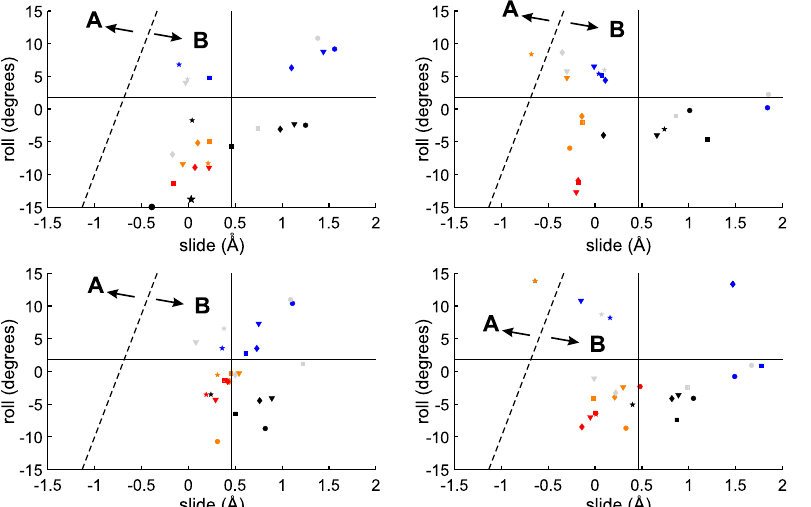
Figure 4. Predicted slide and roll coordinates of single-stranded hexamers. ( Top ): M06-2X; ( bottom ): B3LYP-D3. ( Left ): 6-31G(d,p); ( right ): TZVP. Blue: ss-A 6 ; orange: ss-C 6 ; black: ss-G 6 ; red: ss-T 6 ; gray: ss-A 2 C 2 A 2 . • : 5 (cid:48) -B ( 1 ) /B ( 2 ) steps; (cid:72) : B ( 2 ) /B ( 3 ) steps; (cid:7) B ( 3 ) /B ( 4 ) steps; (cid:4) : B ( 4 ) /B ( 5 ) steps; and (cid:70) : B ( 5 ) /B ( 6 ) -3 (cid:48) steps. The average slide and roll of the starting calf-thymus B-DNA conformation are reported as full lines. The dashed line separates the A- and B-DNA forms [62].